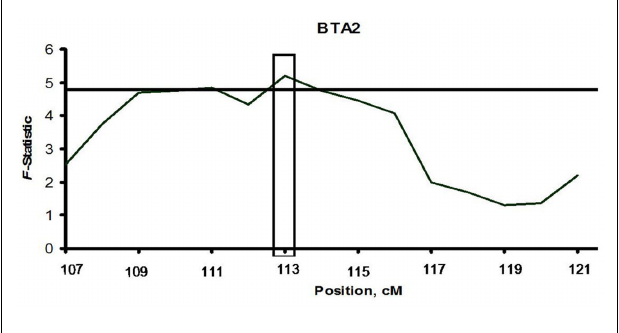
FIGURE 1 | Linkage of bovine respiratory disease with BTA2 with a single locus model in two half-sib sire families. The computed F -statistic is shown on the y -axis and chromosomal location is given in centimorgans (cM) on the x -axis.The boxed regions identify the locus linked with bovine respiratory disease ( P < 0.05) after 5,000 permutations.The horizontal line represents the significance threshold of P = 0.05.